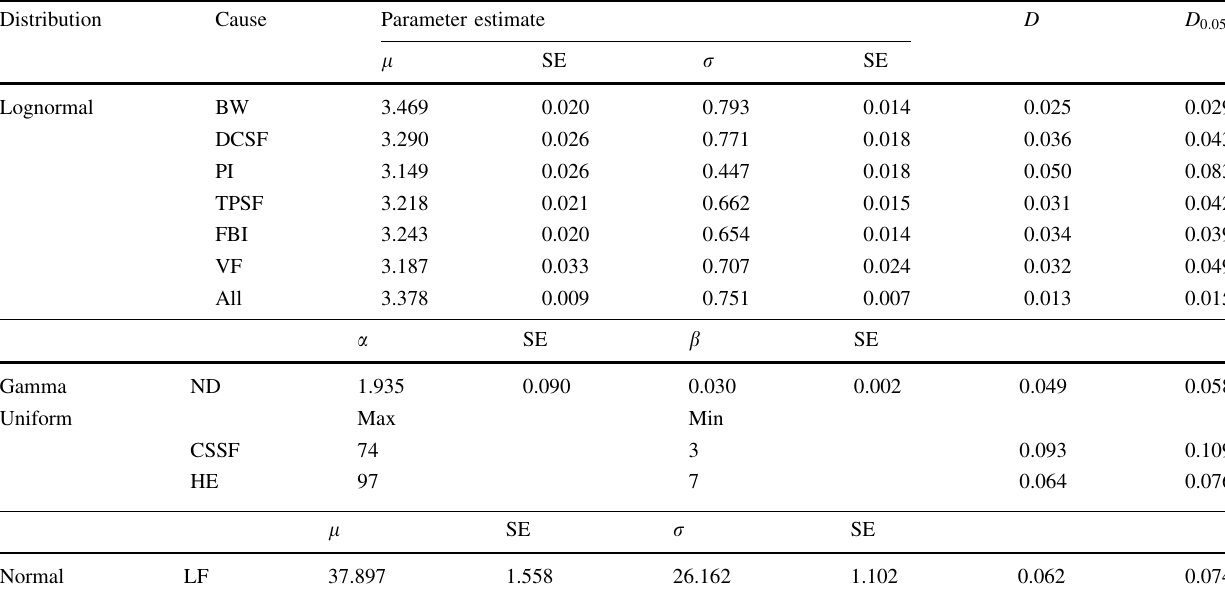
Table 6 Parameter estimate results of the best distributions Distribution